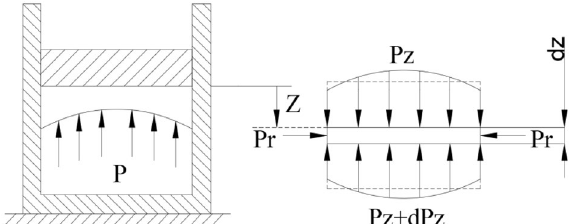
Figure 2. Material pressure distribution in mold.